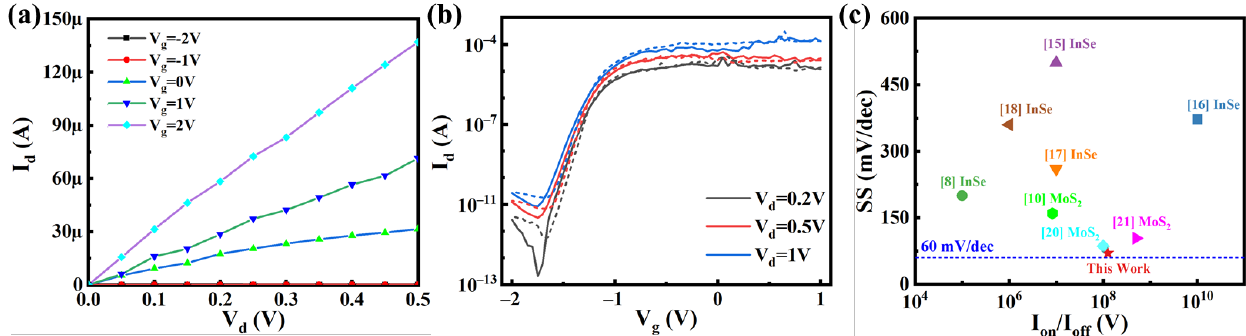
Figure 4. Output characteristic curves ( a ) and transfer characteristic curves ( b ) of non-lithographed device. The solid and dotted lines represent voltage scanning from −2 to 2 V and from 2 to −2 V, respectively. ( c ) Benchmark of SS and on/off ratio of transistors in different studies, including research on InSe and MoS 2 .